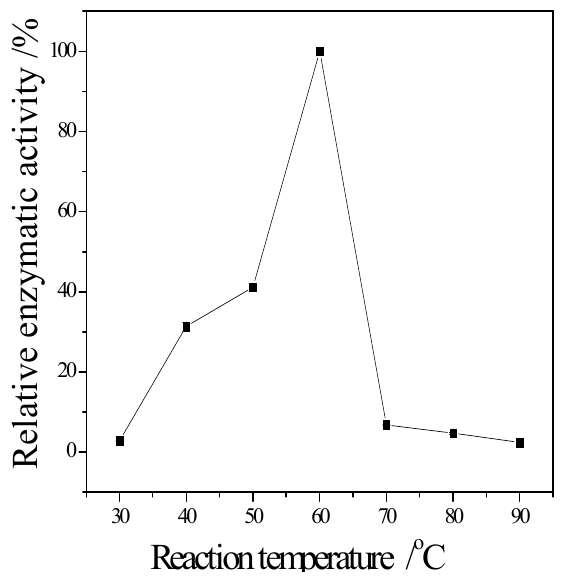
Figure 4. Effect of reaction temperature on enzymatic activity.